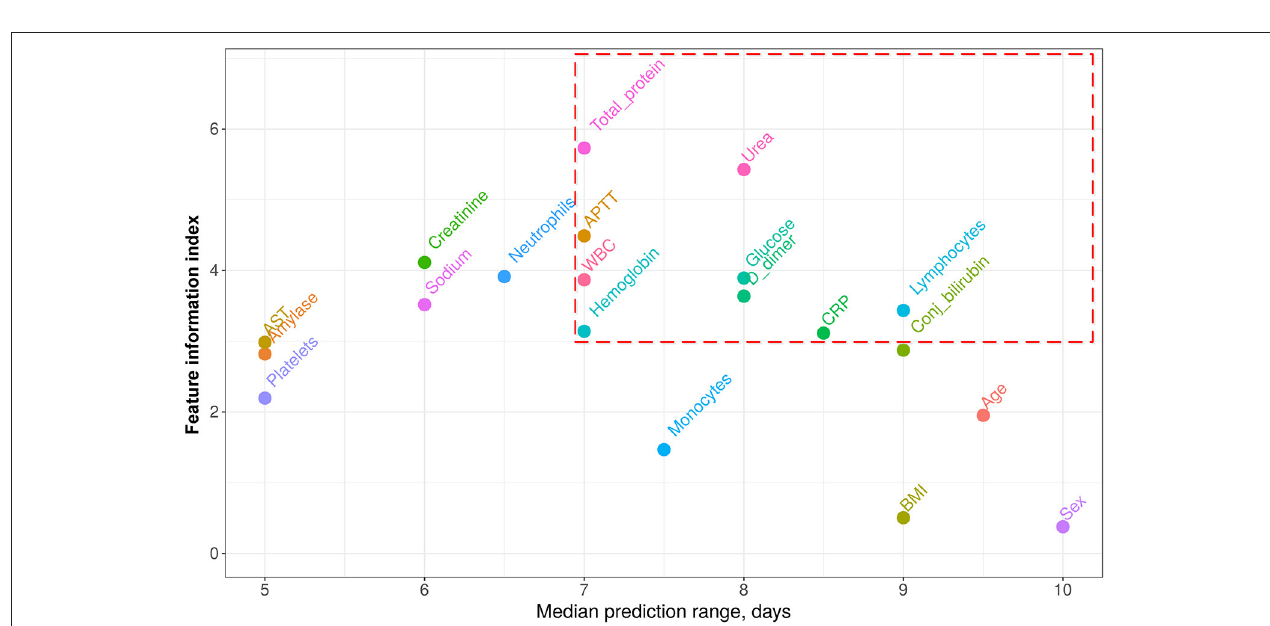
FIGURE 3 | Features informativeness indexes (FII) vs. median prediction range. Features with prediction range ≥ 7 days range and weight ≥ 3 were accepted as the components of the proposed score (circled with red dashed line). CRP, C-reactive protein; AST, aspartate aminotransferase; APTT, activated partial thromboplastin time; WBC, white blood cells; BMI, body mass index.